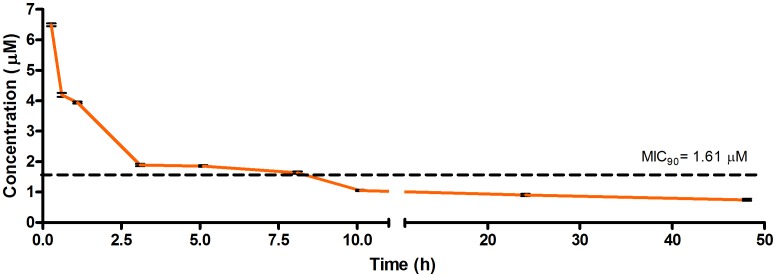
Total concentrations for RMB041 following intravenous administration in an uninfected murine model.